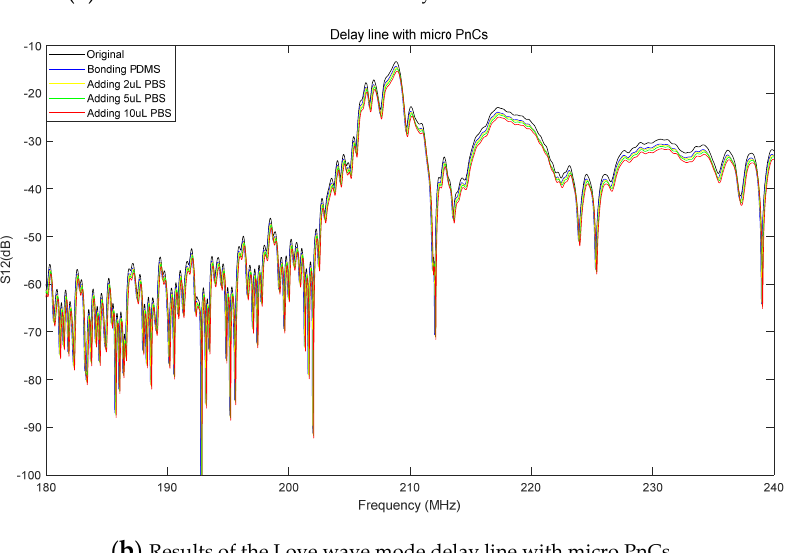
Figure 13. Liquid environmental experimental results of the Love wave mode delay line.